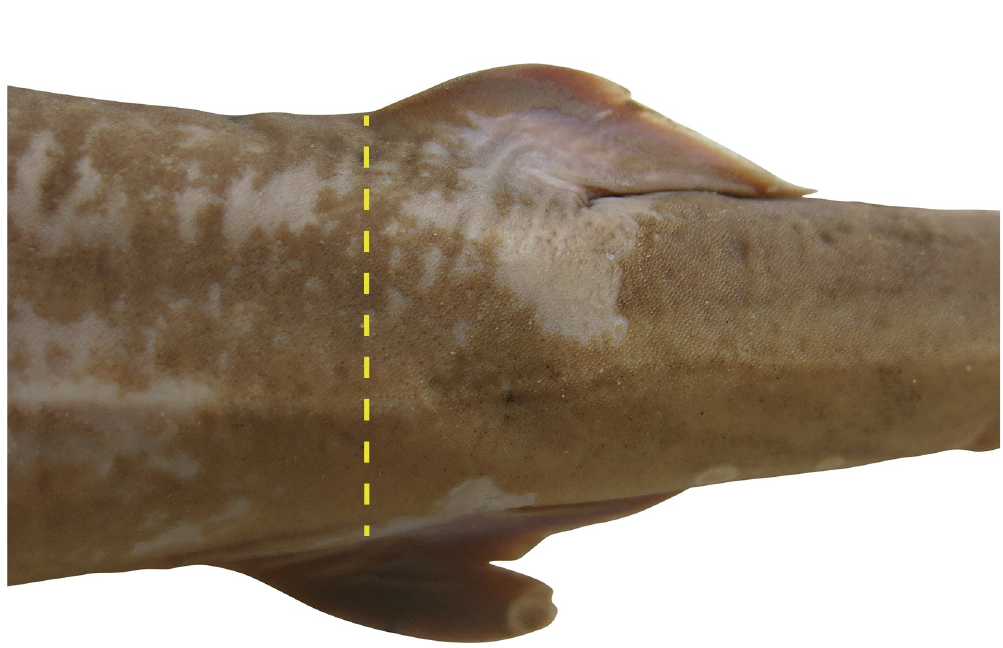
Fig 8. Alignment of second dorsal fin in relation to anal fin of Carcharhinus obsolerus sp. nov. NMW 61463, holotype (433 mm TL female); yellow dashed line indicates alignment of origin of second dorsal fin with anal-fin midbase.